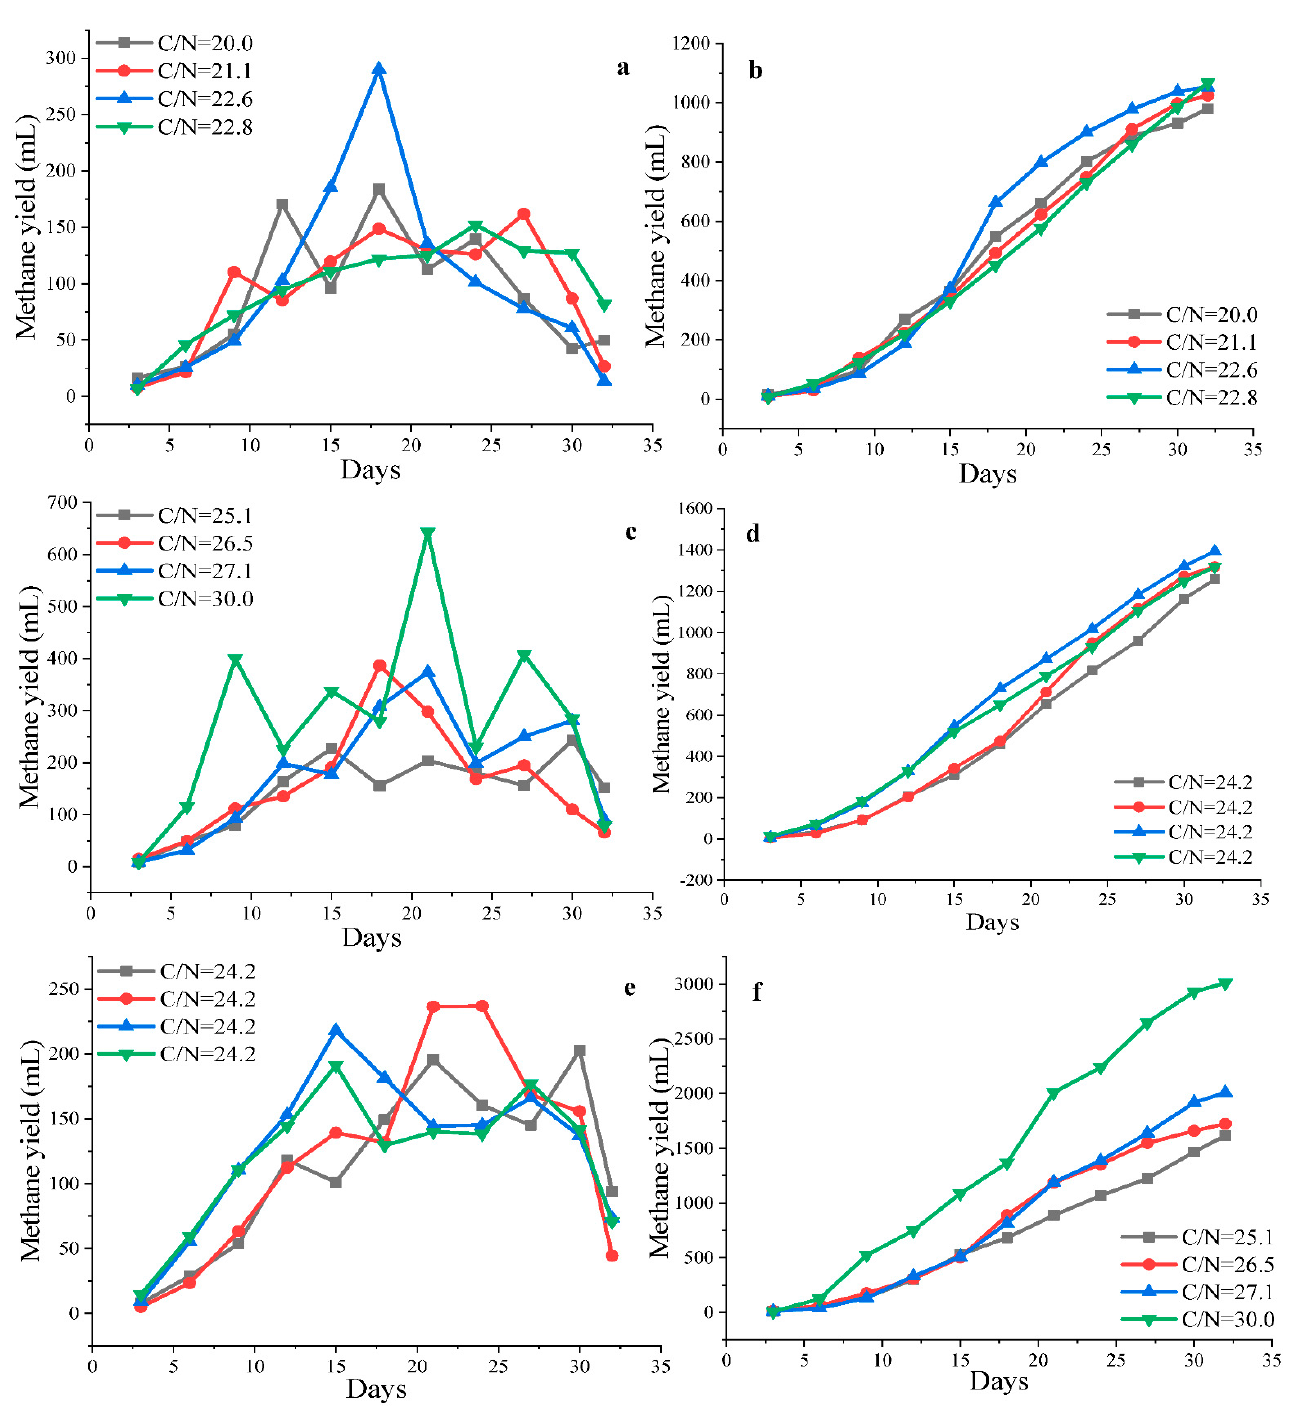
Figure 7. ( a , c , e ) Methane content yield every three days; ( b , d , f ) cumulative methane yield. c and d are the replicates of medium C/N ratio 24.2.